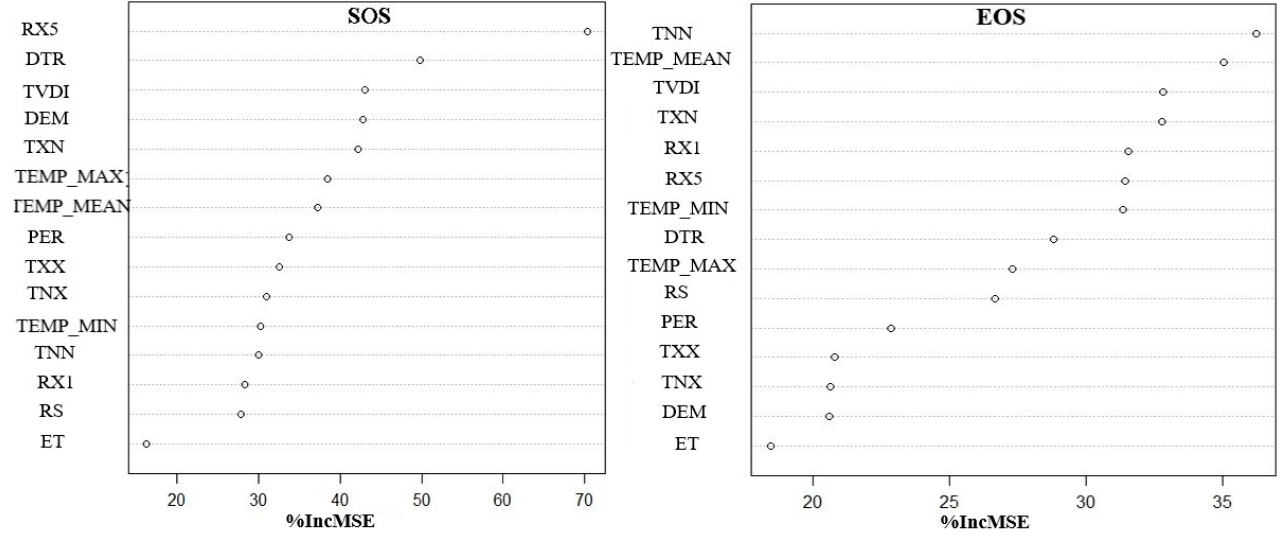
Figure 6. The importance of the climate indices for the phenological parameters start of the growing season (SOS) and end of the growing season (EOS), estimated as the percentage increase in the mean square error (% Inc MSE) of the different vegetation types.